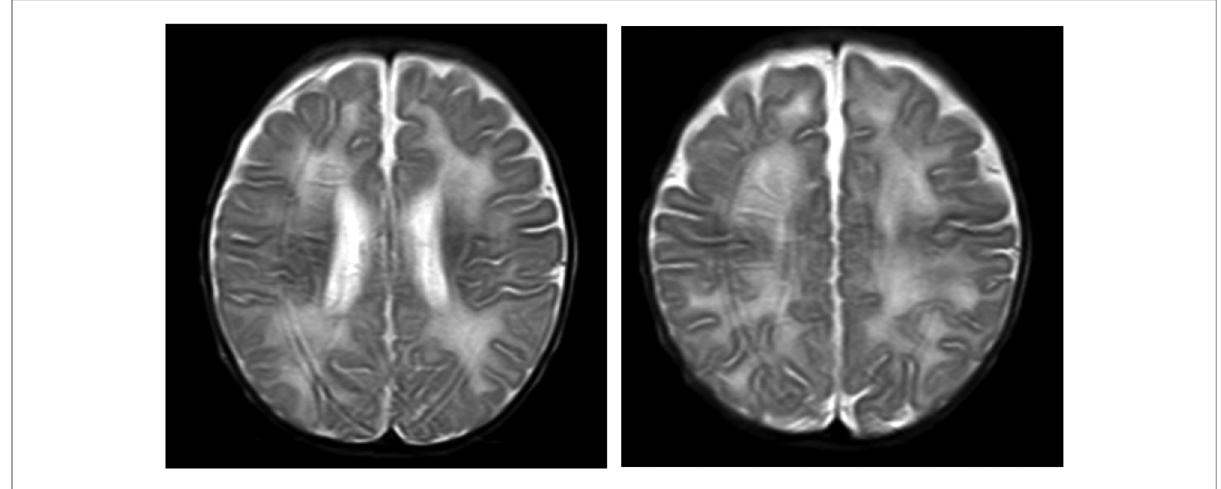
FIGURE 2 Brain MRI. Axial T2-weighted image showing diffuse white matter